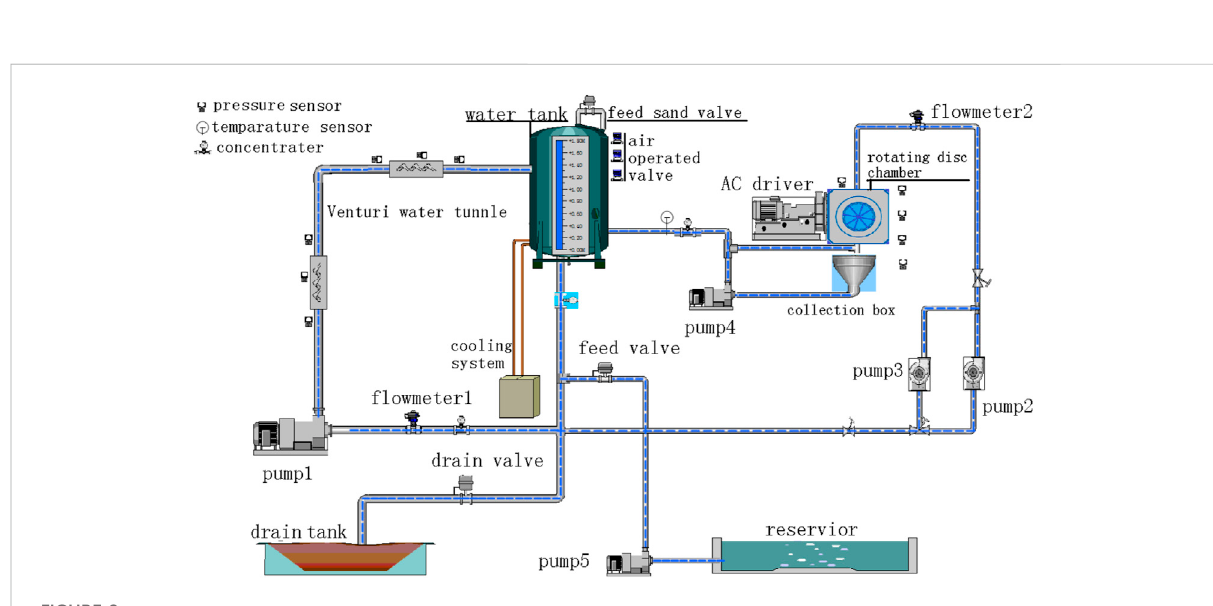
FIGURE 8 The layout of the integrated test rigs at CIWRH (Lu et al.,